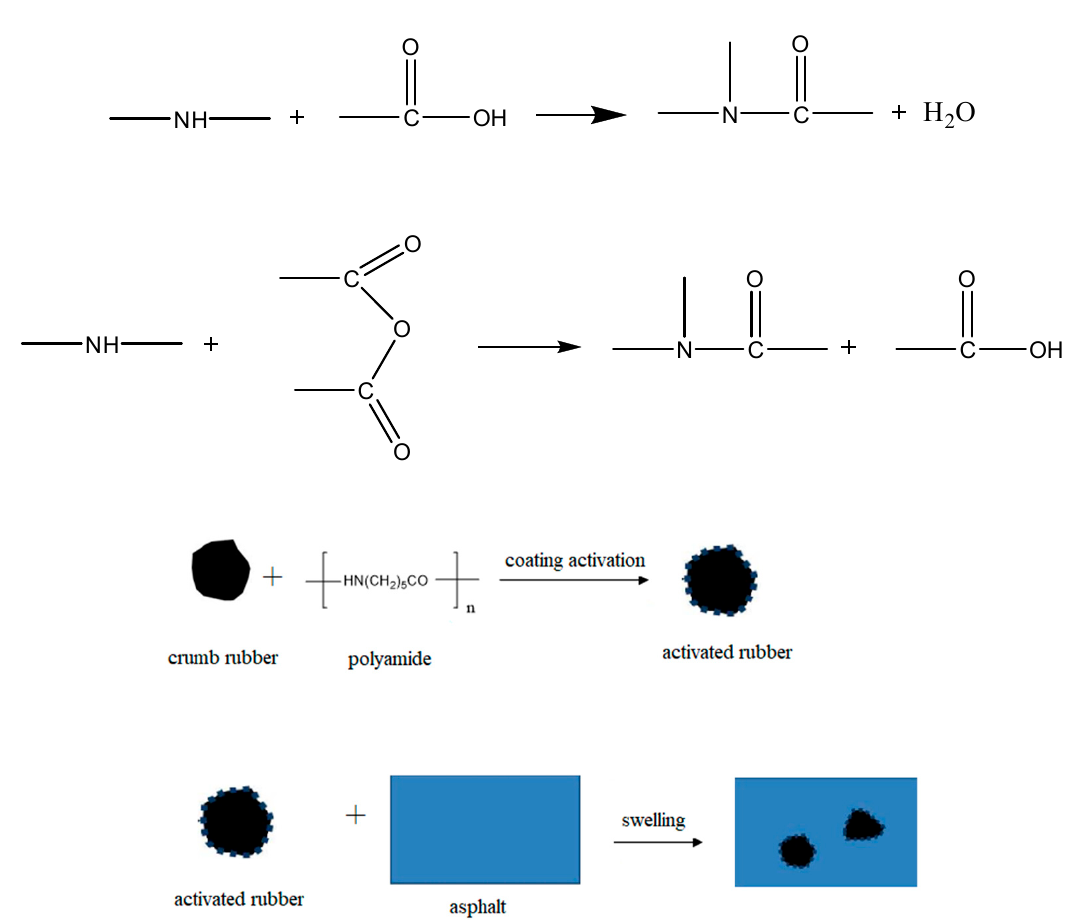
Figure 10. Schematic diagram of the modification mechanism with CR (coating-activated rubber with polyamide 6) .